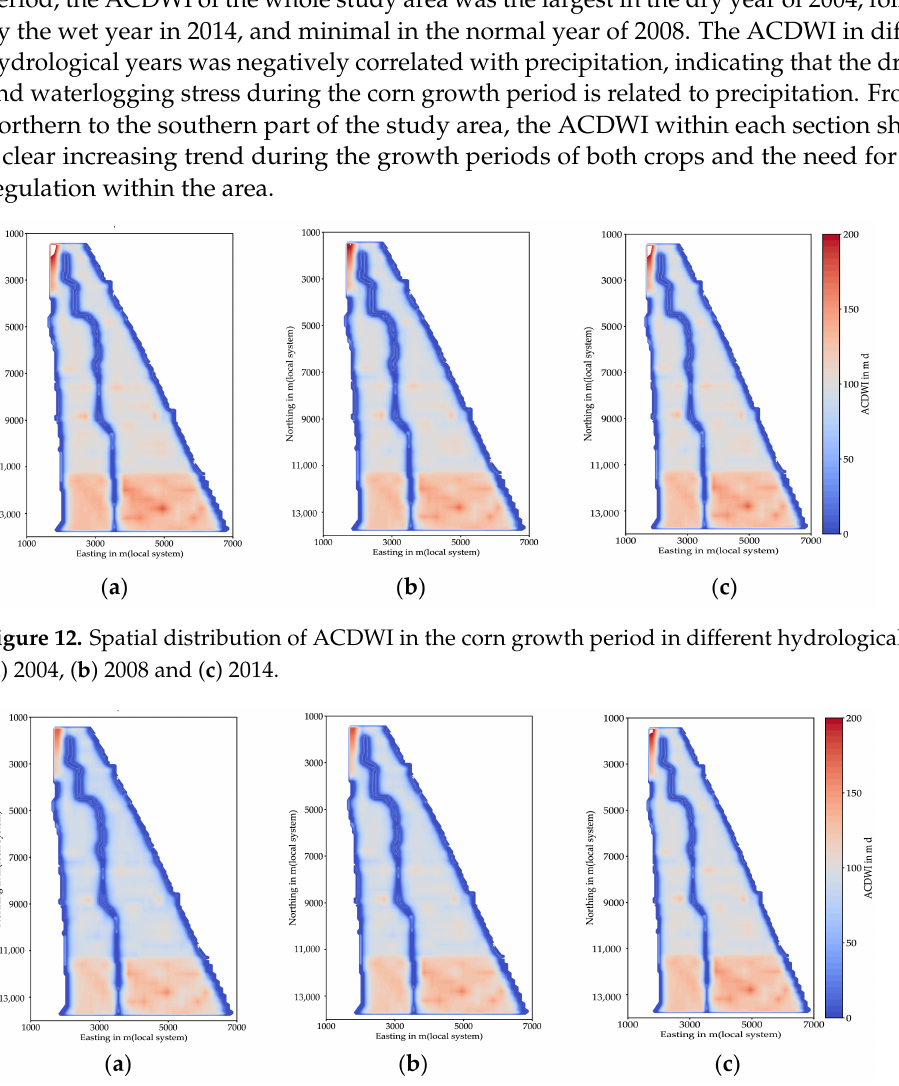
Figure 13. Spatial distribution of ACDWI in the wheat growth period in different hydrological years: ( a ) 2004, ( b ) 2008 and ( c ) 2014. Table 8. Spatiotemporal ACDWI averages for different hydrological years and sections, together with the respective precipitation